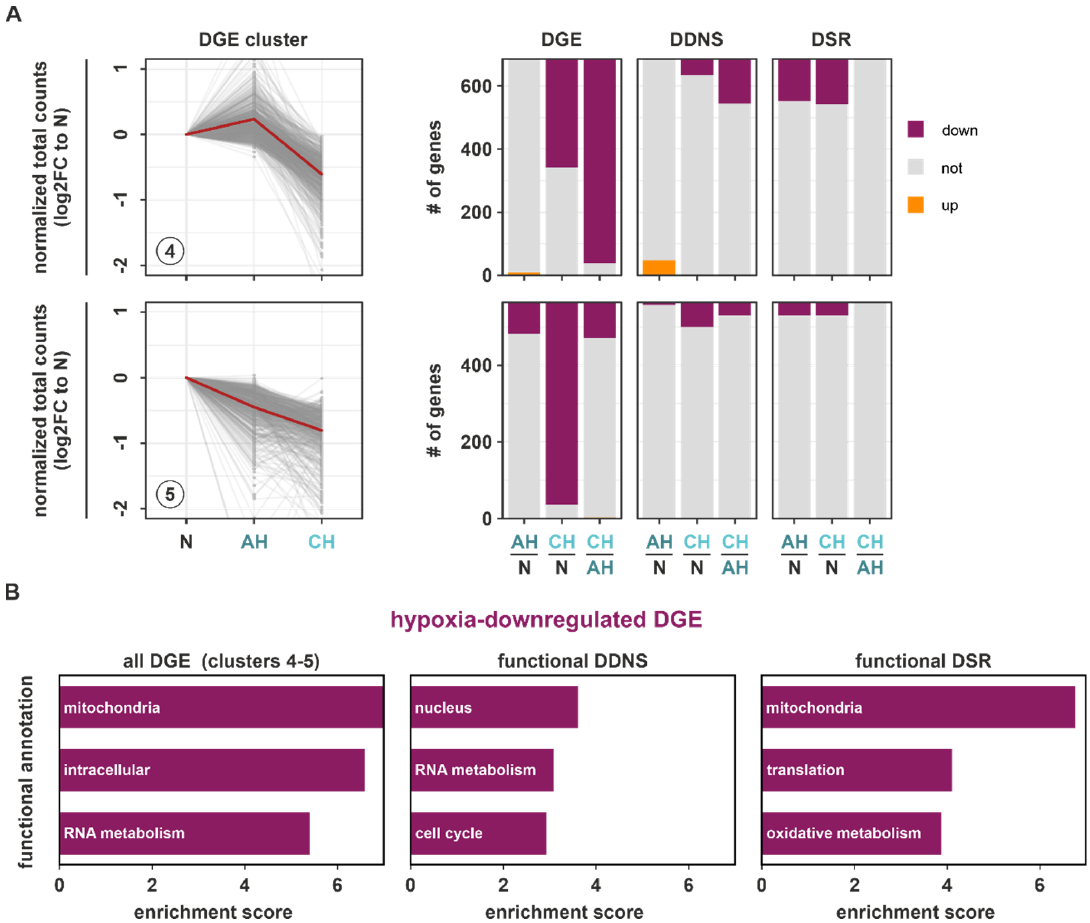
Figure 5. Impact of DSR and DDNS on downregulated DGE targets during hypoxia. ( A ) Changes in the downregulated DGE target clusters (4–5) on the level of DGE, DDNS, and DSR comparing AH and N, CH and N, and CH and AH are depicted as stacked bar graphs. ( B ) Top enriched functional annotations in all downregulated DGE within clusters 4–5 ( left panel ), in functional DDNS, i.e., genes which are downregulated on DGE and DDNS level and unaltered in DSR ( middle panel ), and in functional DSR, i.e., genes which downregulated on DGE and on DSR level and unaltered in DDNS ( right panel ) as determined by DAVID.